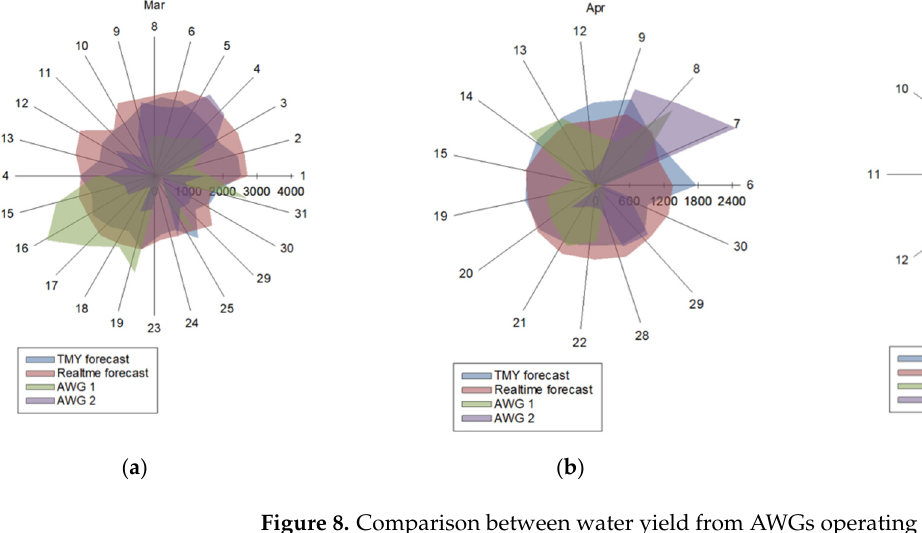
The average temperatures for AWGs 1 and 2 were measured at 20.8 °C and 19.9 °C.